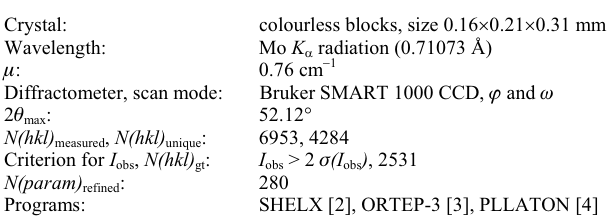
Table 1. Data collection and handling.